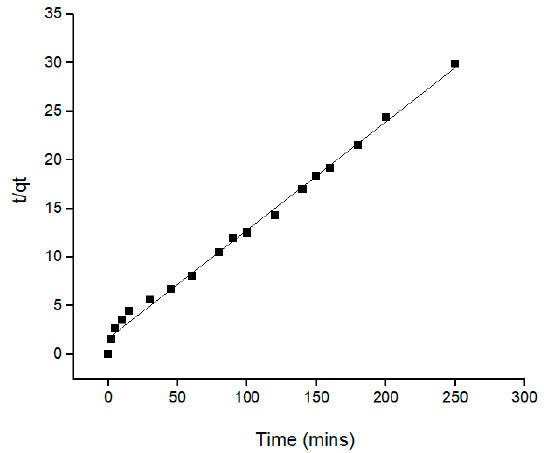
Figure 9. Pseudo-second order kinetic plots for the removal of Pb(II) ions onto Si-TS-SSIL.